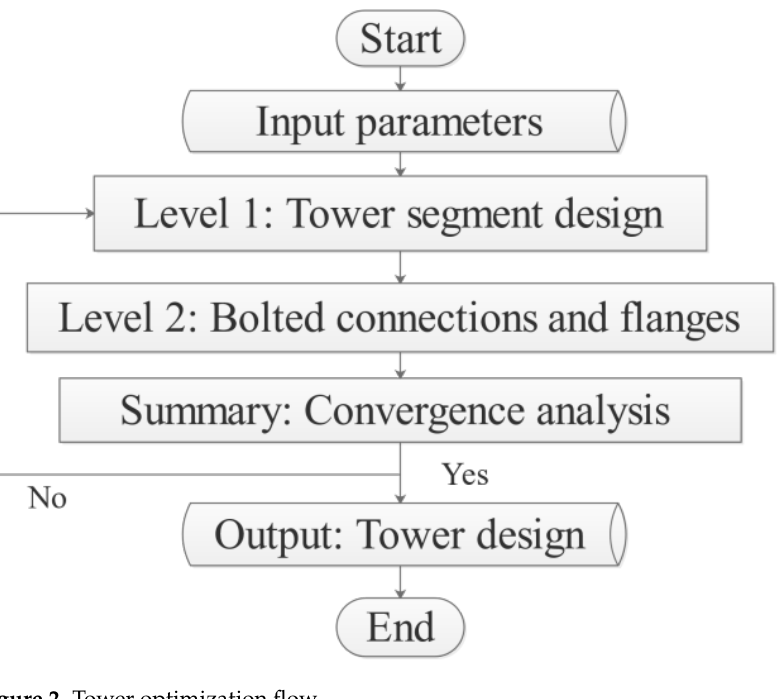
Figure 2. Tower optimization flow.